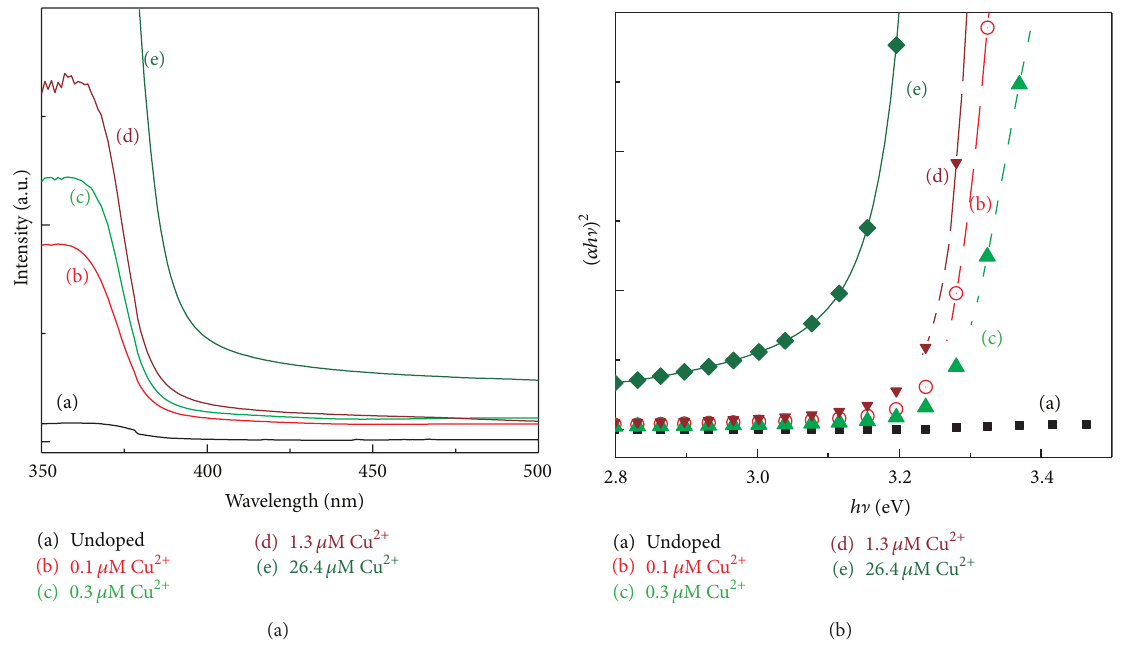
Figure 3: (a) Absorption spectra of doped ZnO films with different concentrations of doping. (b) Tauc plots of the same films.